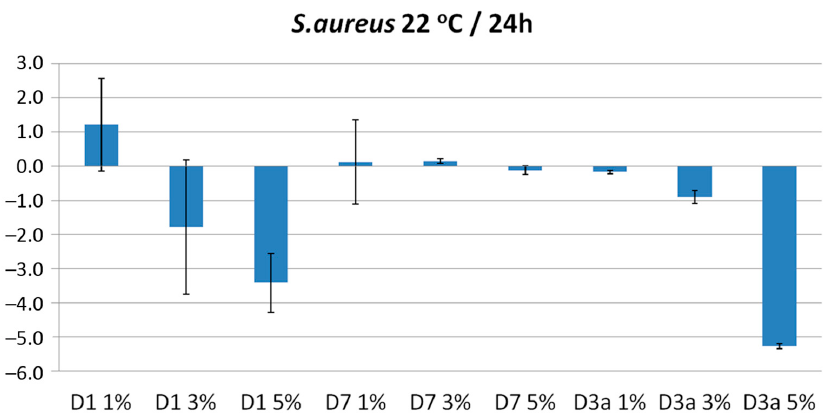
Figure 6. Bacteriostatic effect of polymer blends after 24 h of contact with S. aureus at temperature 22 °C. Each bar represents the log reduction from three independent experiments done in duplicates (mean ± standard deviation).